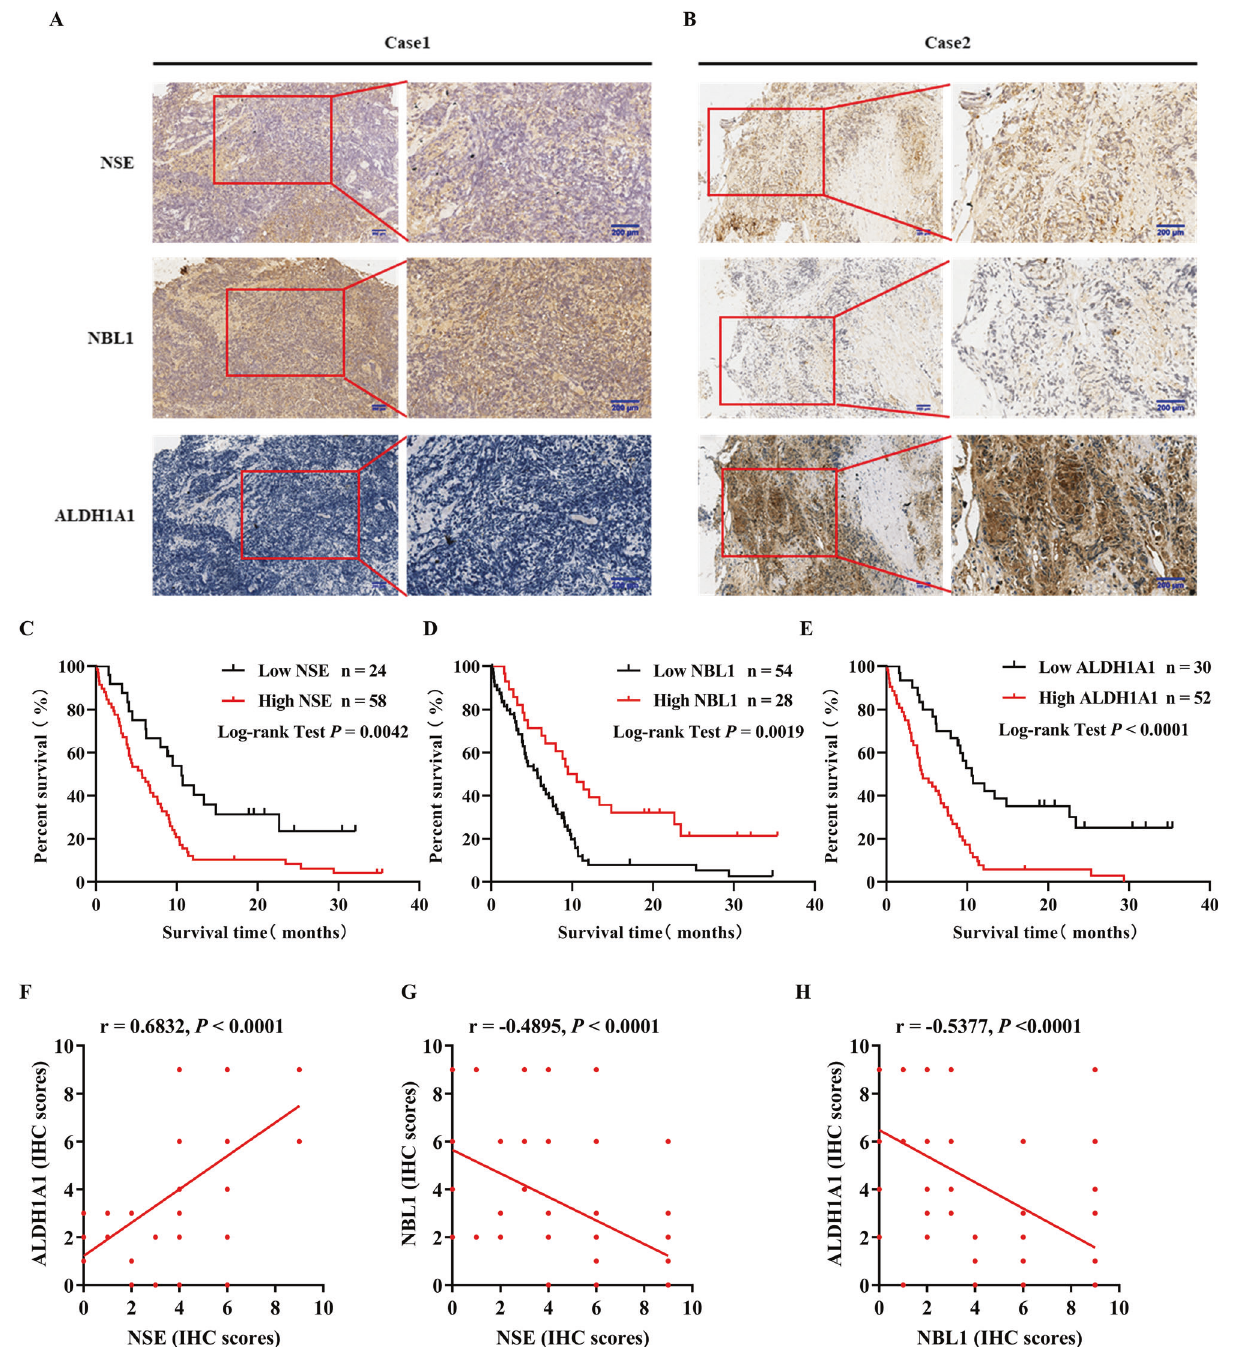
Fig. 7 The clinical signi fi cance of NSE, NBL1, and ALDH1A1 expression in patients with SCLC. In all, 82 cases of SCLC tissues were stained with NSE, NBL1, and ALDH1A1 in serial paraf fi n-embedded tissue blocks. Representative microscopy images of paired NSE, NBL1, and ALDH1A1 staining are shown at 10X and 20X magni fi cations, scale bar 200 μ m. A Images on the left represent one case with high NSE staining, low NBL1 staining, and high ALDH1A1 staining. B Images on the right demonstrate a representative case with low NSE expression, high NBL1 expression, and low ALDH1A1 expression. Kaplan – Meier survival analysis was performed to determine the role of NSE ( C ), NBL1 ( D ), and ALDH1A1 ( E ) expression in predicting the overall survival of patients with SCLC. Spearman ’ s correlation coef fi cient was used to assess the correlation between NSE, NBL1, and ALDH1A1. F Positive correlation between NSE and ALDH1A1 expression. G Negative correlation between NSE and NBL1 expression. H Negative correlation between NBL1 expression and ALDH1A1